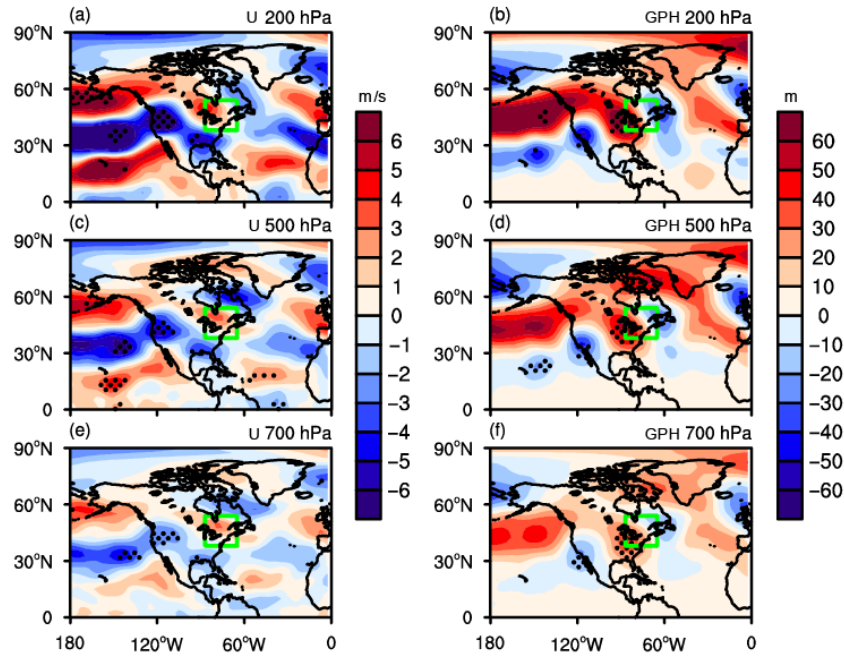
Figure 4. ( a , c , e ) Composite differences in April zonal wind (m/s; from NCEP2) between positive and negative ASO anomaly events during 1985 – 2019. ( b , d , f ) Same as ( a , c , e ), but for geopotential height. Black dots denote those regions with significant correlation coefficients at the 95% confidence level. Detailed anomalous events can be found in Table 1.